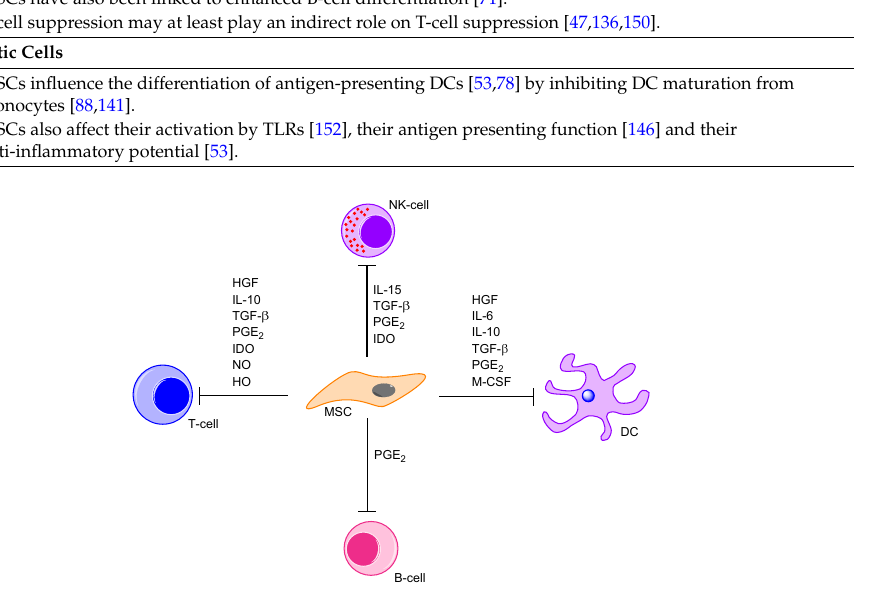
Figure 4. Immunosuppressive effects of mesenchymal stem cells. MSCs excrete various cytokines that mediate immunosuppression of T-cells, B-cells, natural killer cells (NK) and dendritic cells (DC). Some mediators, like prostaglandin E2 (PGE 2 ), exhibit an immunosuppressive effect on all immune cells, whereas others, like IL-15, are specific inhibitors of single cell